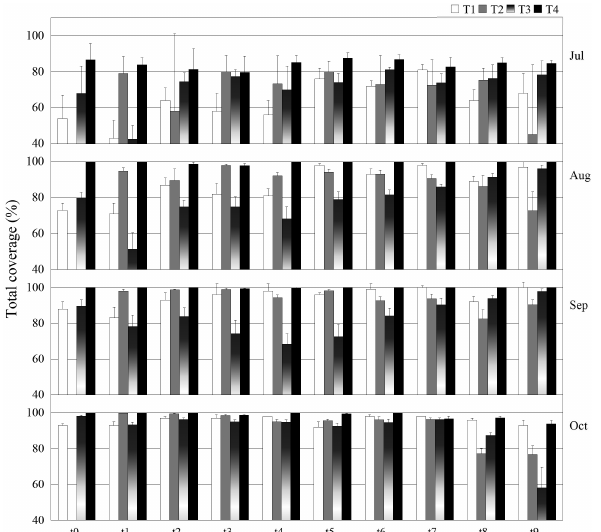
Figure 2. Total coverage of different combinations of shrub and herbaceous seeds ( ± SE) from July to October 2013; see Table 3 caption for code identification.